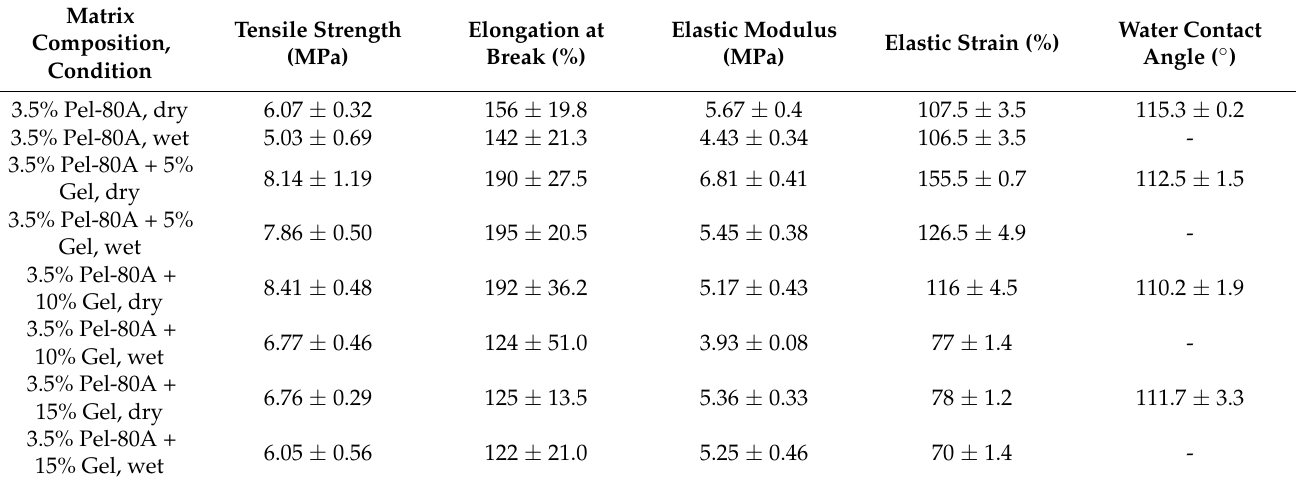
Table 1. Physical characteristics of Pel-80A-based electrospun